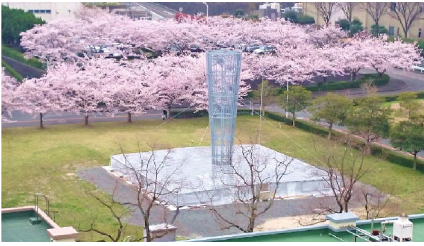
Figure 15: The wind solar tower prototype in Chikushi Campus, Kyushu University.